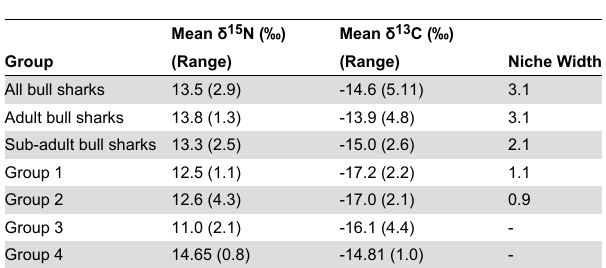
Table 2. A summary of the mean δ 15 N and δ 13 C values for all groups and calculated niche widths of adult and sub- adult bull sharks and fish groups 1 and 2.